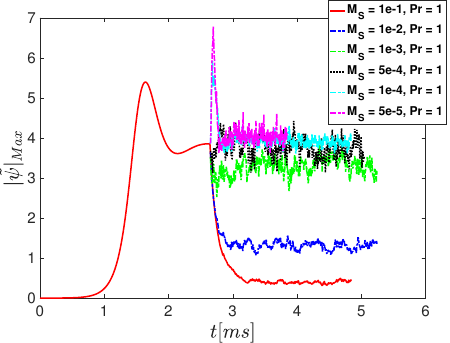
Figure 8. Time evolutions of the | ˜ ψ | Max for (1,1) mode for Pr = 30 (black solid line) and Pr = 1 (all other lines) for various levels the Mach number of the stochastic ZFs, M S